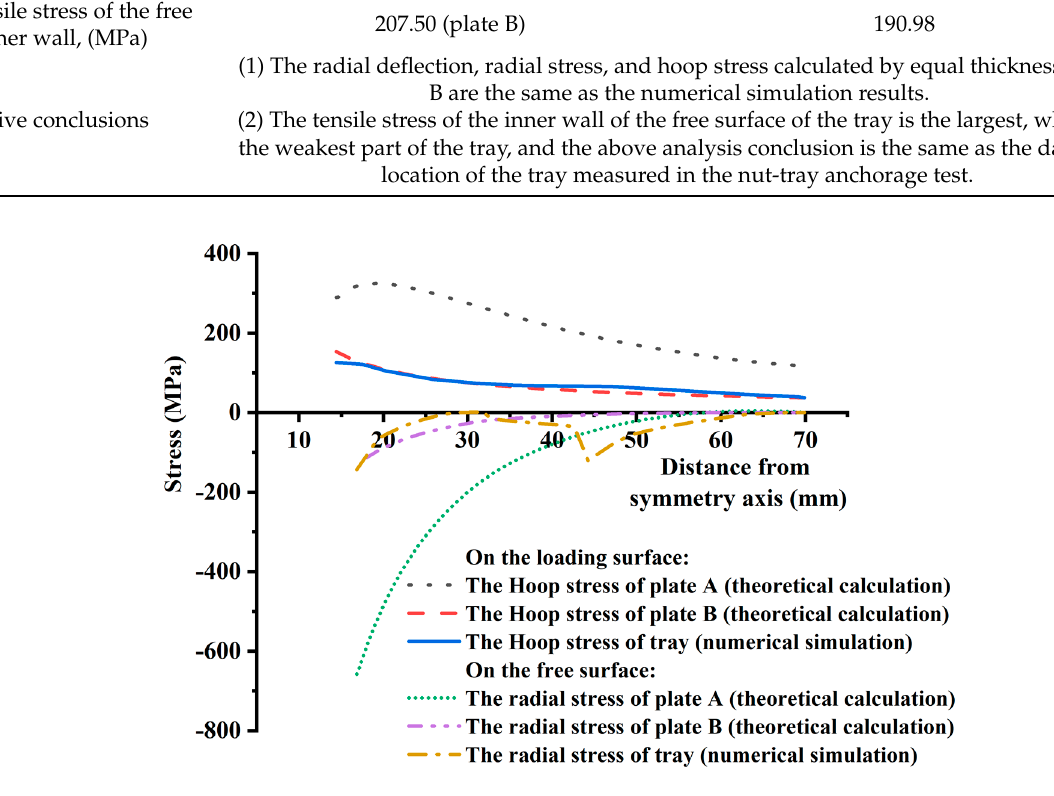
Figure 17. Comparison of stress distribution between theoretical analysis and numerical simulation of the tray.